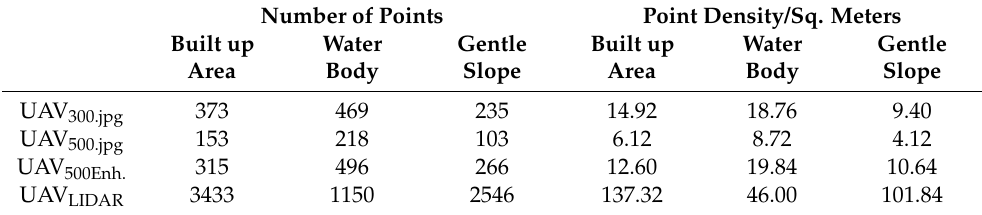
Table 5. Point density at different Landcover classes. Number of